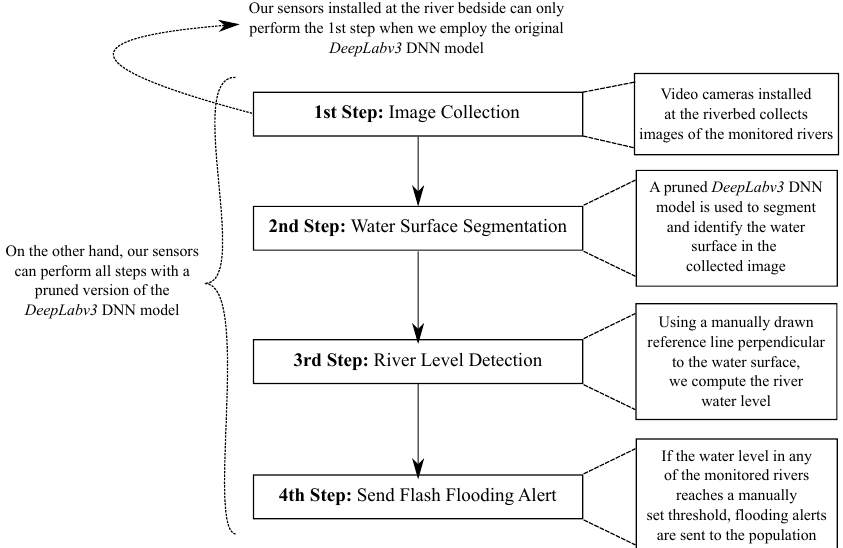
Figure 3. Overview of the proposed river flooding detection system.